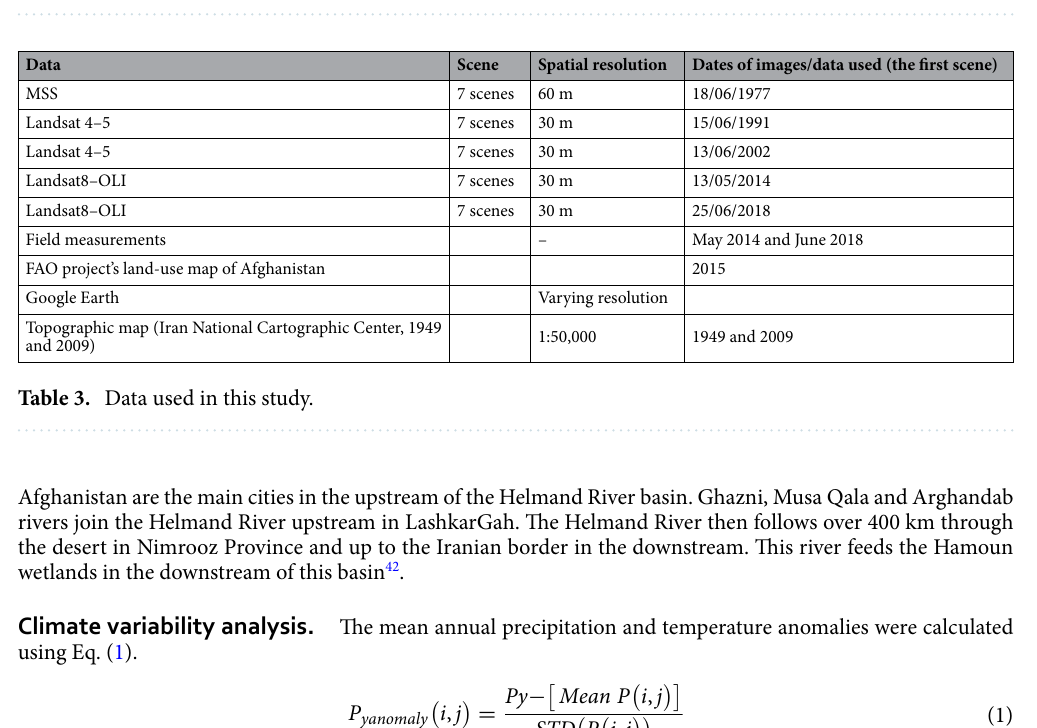
Figure 8. Helmand river basin. ( Source : the satellite image was downloaded freely from www. https:// earth explo rer. usgs. gov and processed by QGIS 3.16 https:// qgis. org/ en/ site/ forus ers/ downl oad. html and ArcGIS 10.5.1 https:// www. esri. com/ en- us/ home).